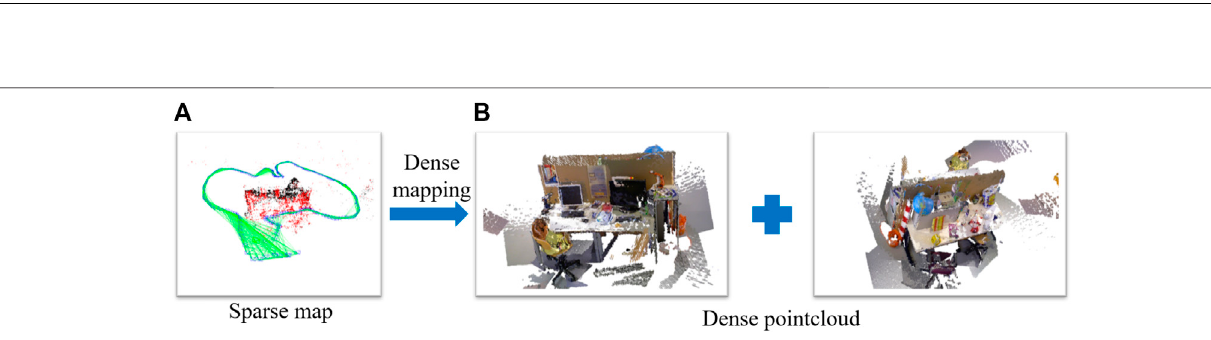
Frontiers in Energy Research |